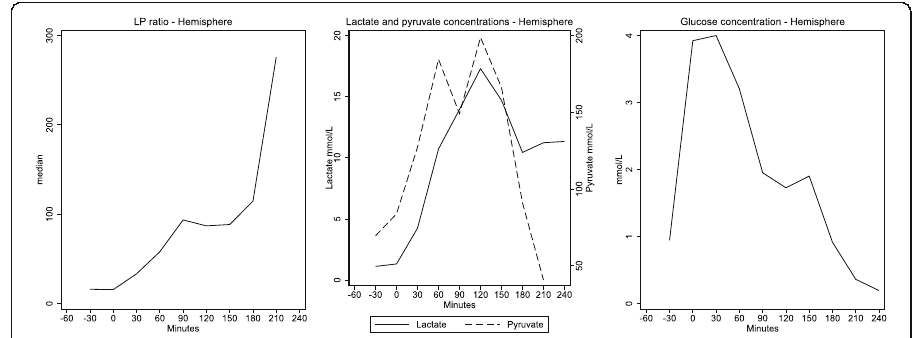
Fig. 5 Irreversible metabolic perturbation. 60 min hypoperfusion. LP ratio and microdialysis levels of lactate, pyruvate, and glucose in brain parenchyma doing hemorrhagic shock in pig showing signs irreversible metabolic perturbations. Note that LP ratio rises almost exponentially. This increase is due to a constant elevated lactate level and a temporary rise in pyruvate level. After re-infusion of blood, a marked decrease in hemisphere glucose is seen. Time 0 indicates achievement of MAP equal to 40